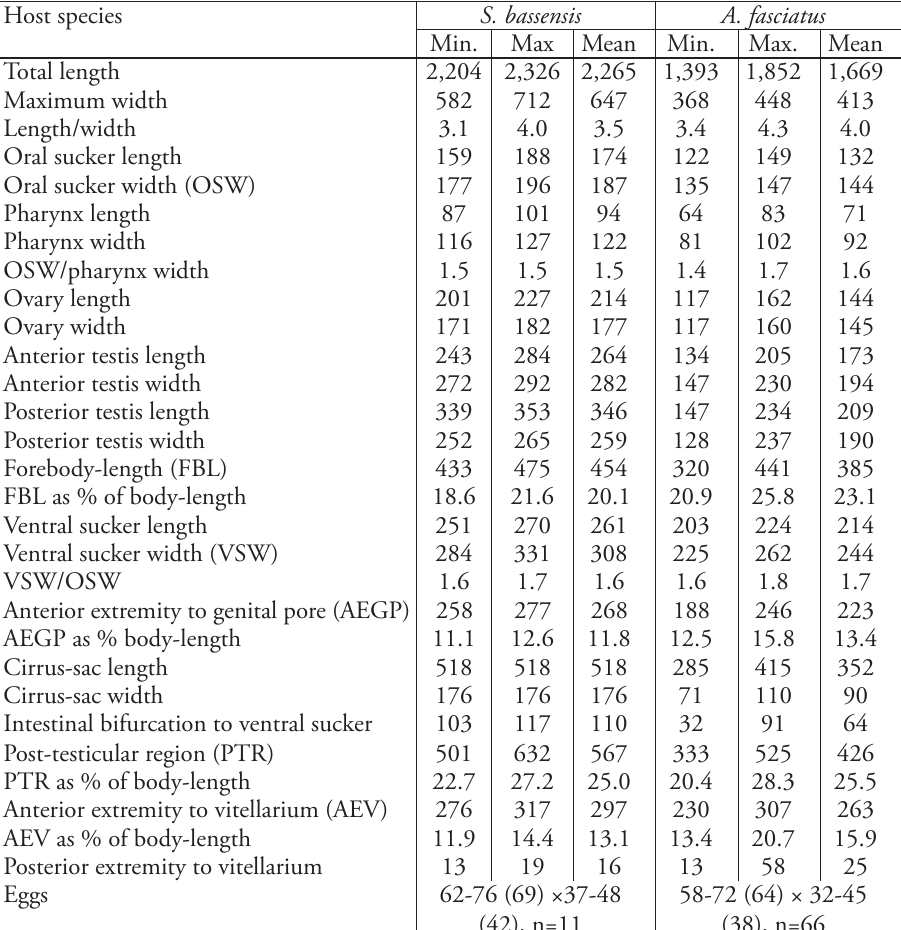
Table 1. Measurements (in μm) of Macvicaria shotteri n. sp. from Sillago bassensis (n = 2) and Apogon fasciatus (n =